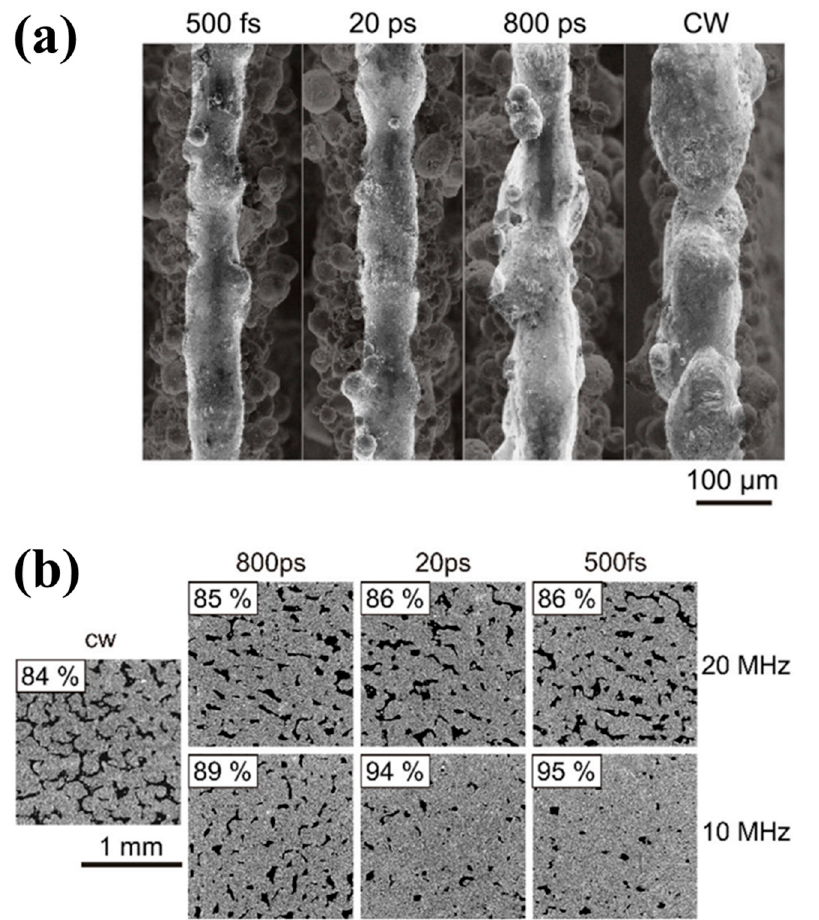
Figure 7. ( a ) SEM images of walls (top view) produced at different pulse width. ( b )The corresponding relative densities of the samples produced using different pulse durations and repetition rates obtained by X-ray CT [15].